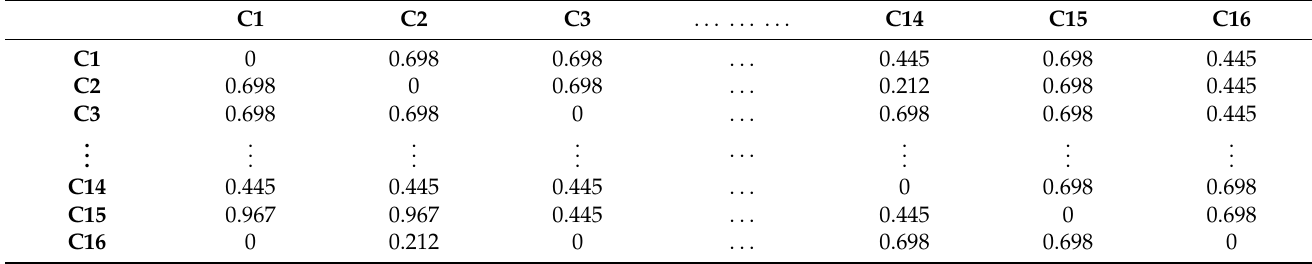
Table 7. Total normalized crisp